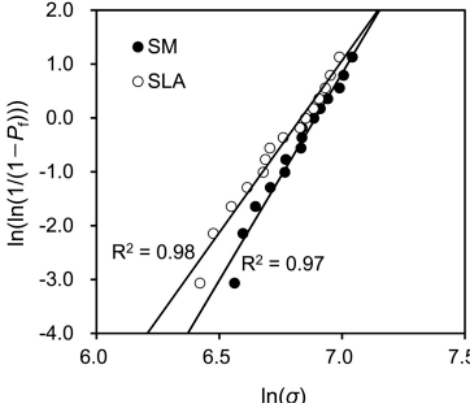
Figure 5. Weibull plots of the three-point flexural strength of the SM- and SLA-fabricated Y-TZP ceramics. The solid lines were obtained from a least-squares fit of the data.